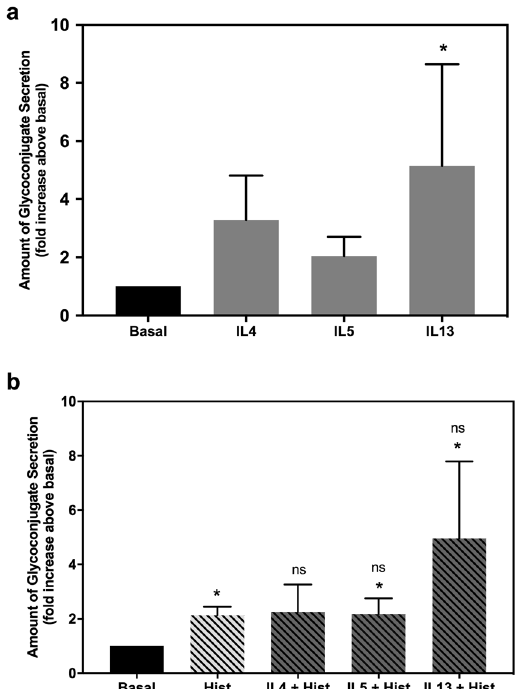
Figure 9. Effect of cytokines alone or on histamine stimulated rat conjunctival goblet cell secretion. (a) Glycoconjugate secretion stimulated with 10 ng/ml IL4, IL5, or IL13 for two hours. ( b ) Glycoconjugate secretion stimulated by 10 − 5 M histamine (Hist) alone for two h or after pretreatment for 30 min with IL4, IL5 or IL13. Data are mean ± SEM from five independent experiments. * indicates statistical significance compared to basal values; ns indicates no significance from histamine